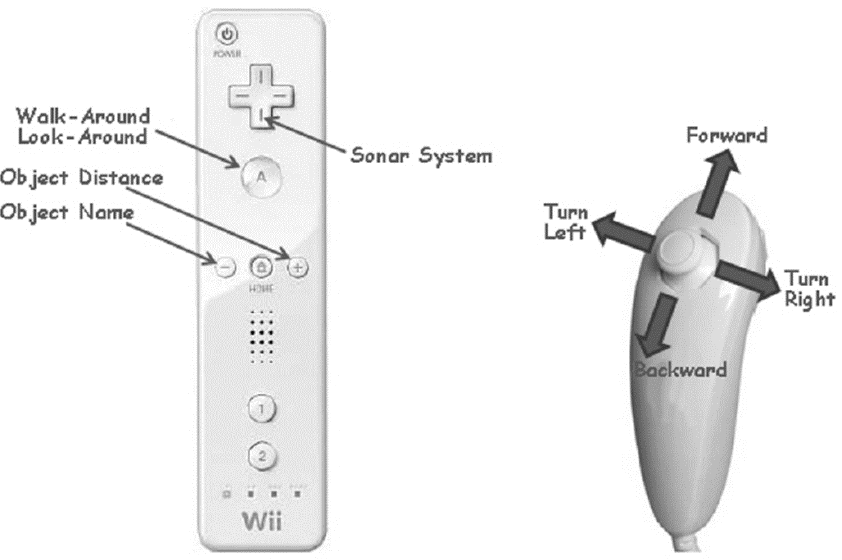
Figure 6. The Wiimote remote controller ( left ) and Nunchuck controller ( Right ).